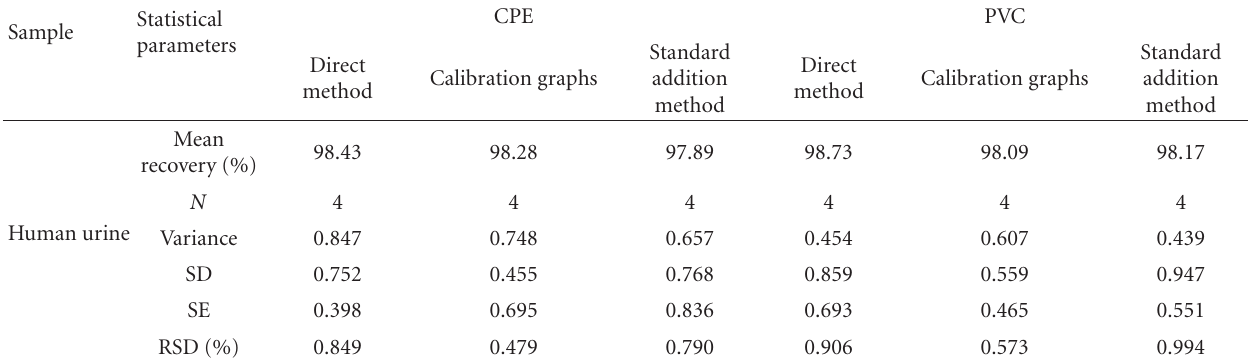
Table 4: Determination of KTF in spiked human urine using CPE and PVC membrane electrodes.